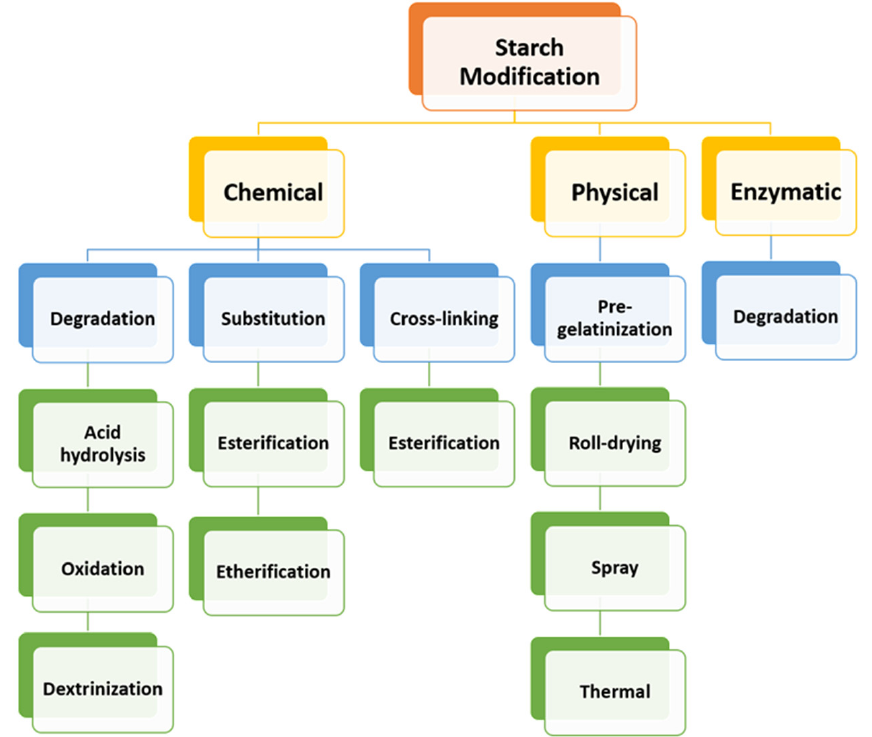
Figure 10. Methods of starch modification.